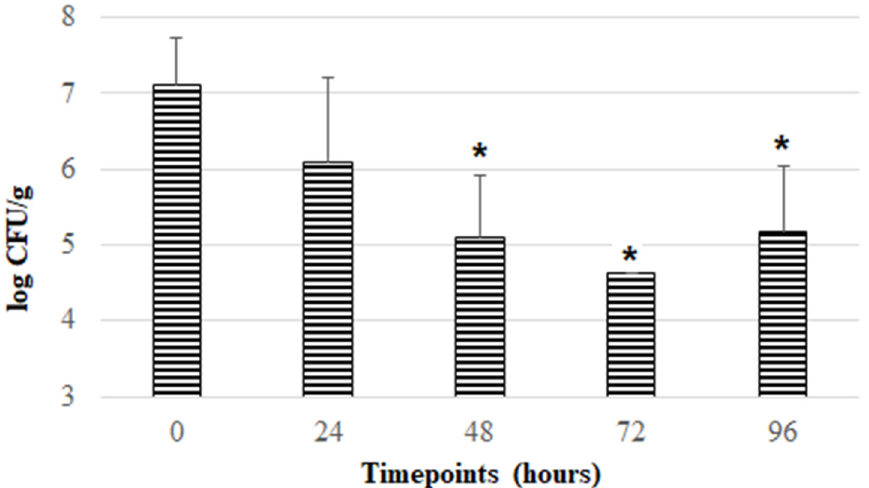
Figure 2. Evolution of viability of F. duncaniae DSM 17677 (mean values in log CFU/g) incorporated in freeze-dried formulation containing inulin, sucrose, cysteine, and riboflavin during aerobic storage at room temperature throughout 96 h. Error bars represent standard deviation of the mean. Bars marked with * represent statistically significant differences ( p < 0.05) in comparison to data reported at 0 h.